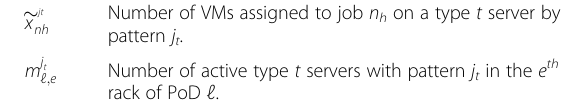
Table 1 Summary of notation